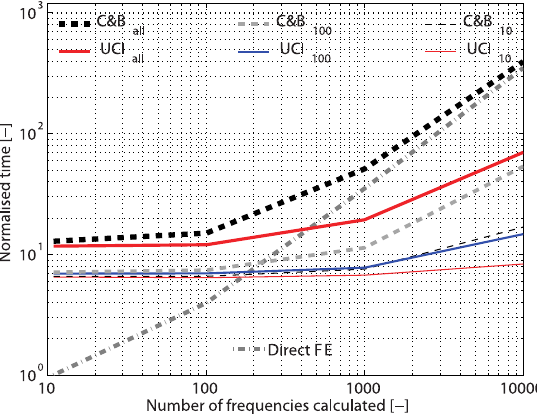
Fig. 12. Model geometry and inspiration geometry of the linking arm. (a) Inspiration geometry, the linking arm of a vehicle suspension sys- tem together with two additional rods; (b) Model geometry, the mesh used to model the linking arm, red parts representing rubber parts, blue part representing steel